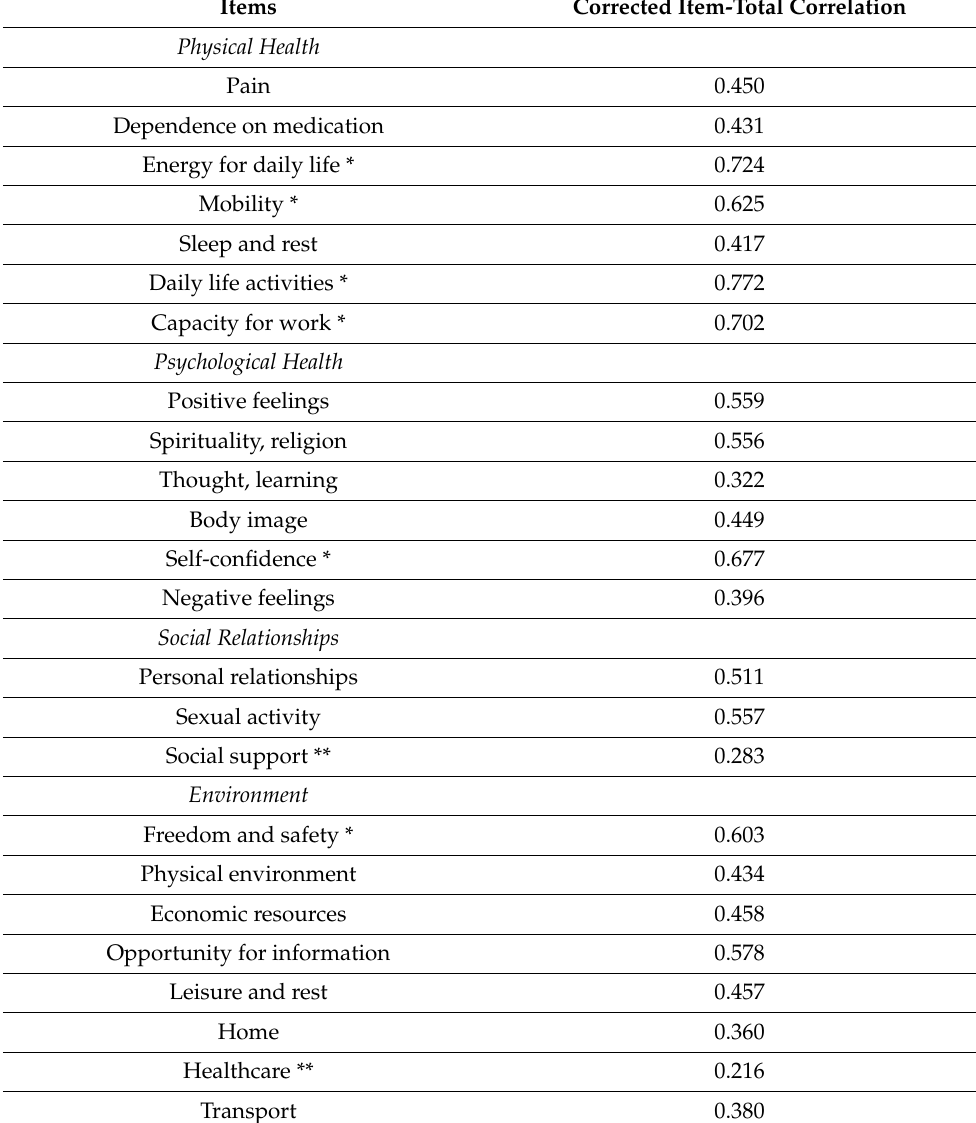
Table 4. Results of item–test correlation and internal